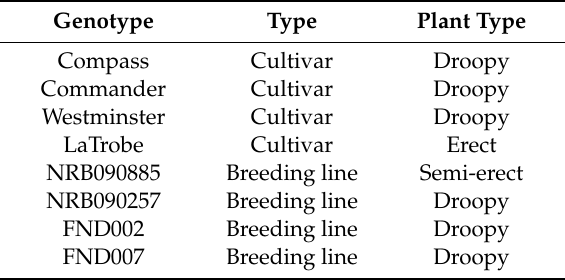
Table 1. Australian barley genotypes, their type, and their classification based on plant type.